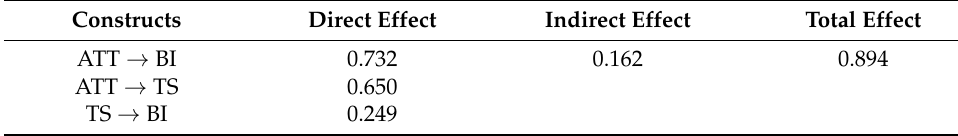
Table 12. Mediating effect of transaction